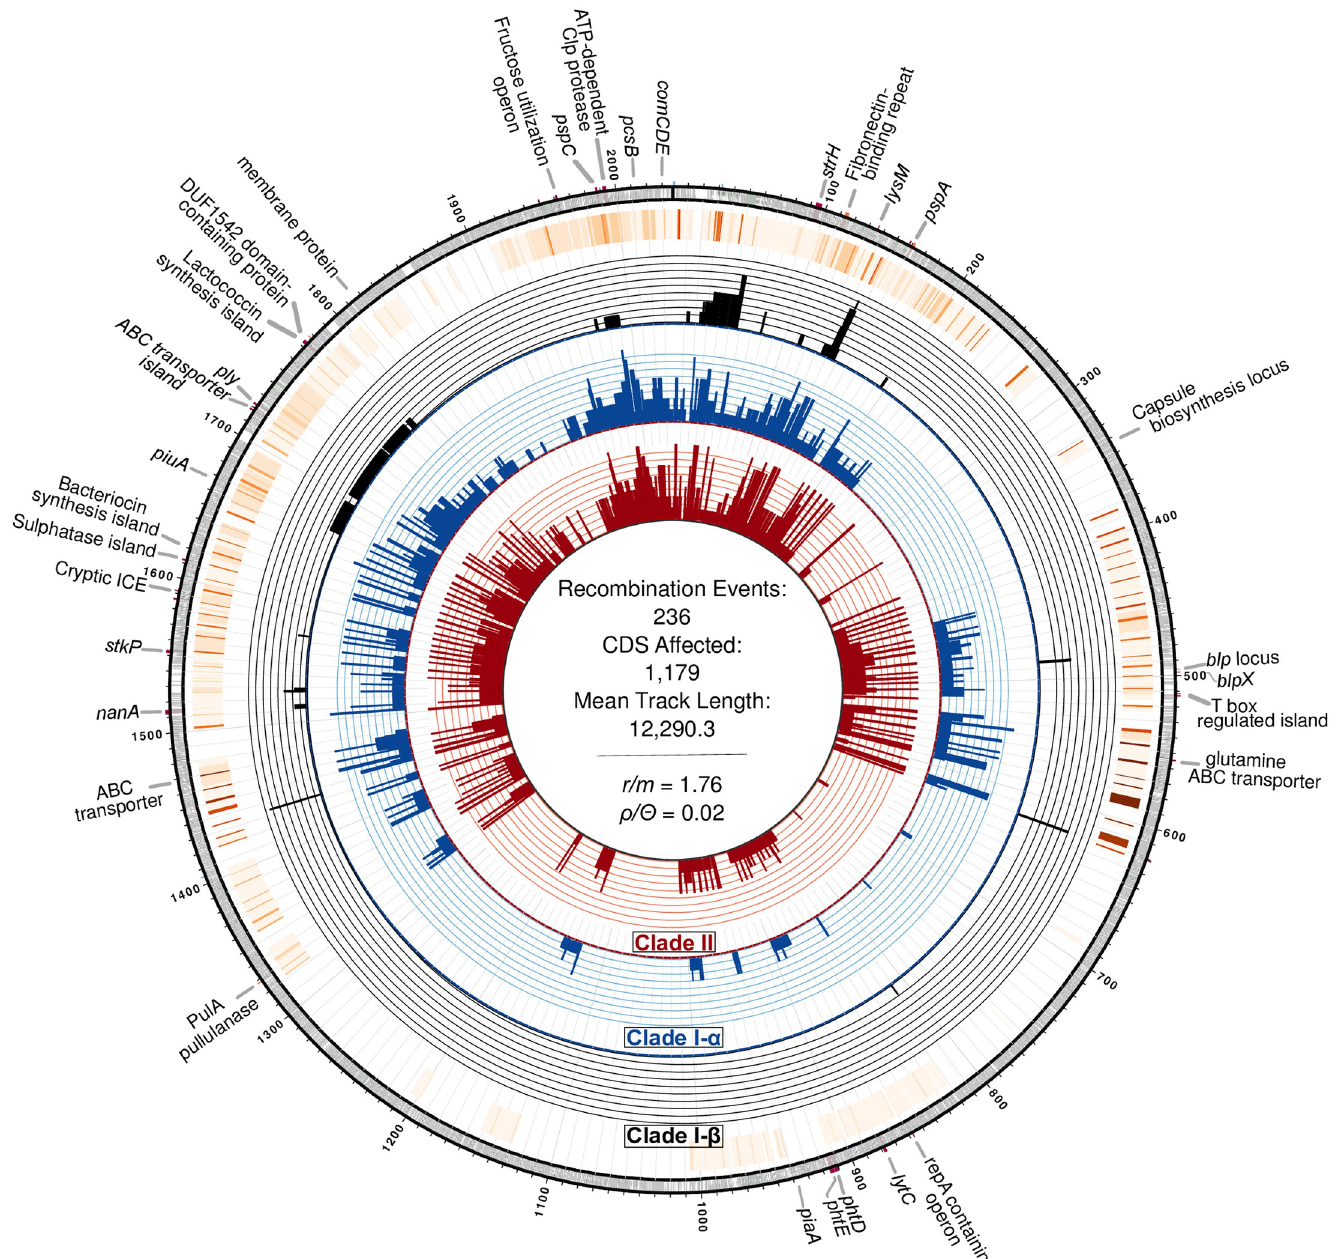
Fig 7. Circos plot of recent and ancestral recombination events inferred among CC180 serotype 3 isolates. Moving from the inner ring outward, rings show a histogram of unique recombination events occurring among isolates belonging to Clades I- β ,I- α ,and II, respectively, followed by a heatmap of cumulative recombination events. Finally, the outermost ring displays annotations of notable genes and genomic regions corresponding to the location on the OXC141 reference genome.